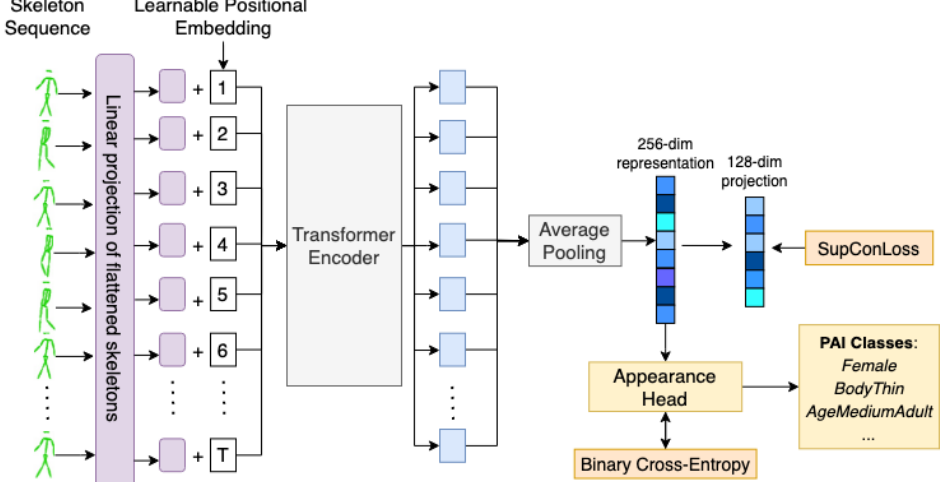
Figure 5. Overview of GaitFormer (Multi-Task) training procedure. Flattened skeletons are linearly projected using a standard feed-forward layer and fed into a transformer encoder. The vectorized representations are average pooled and the resulting 256-dimensional vector is used for estimating the identity and to estimate the 42 appearance attributes through the “Appearance Head”. The contrastive objective (SupConLoss) is applied to a lower 128-dimensional linear projection, similar to the approach in SimCLR